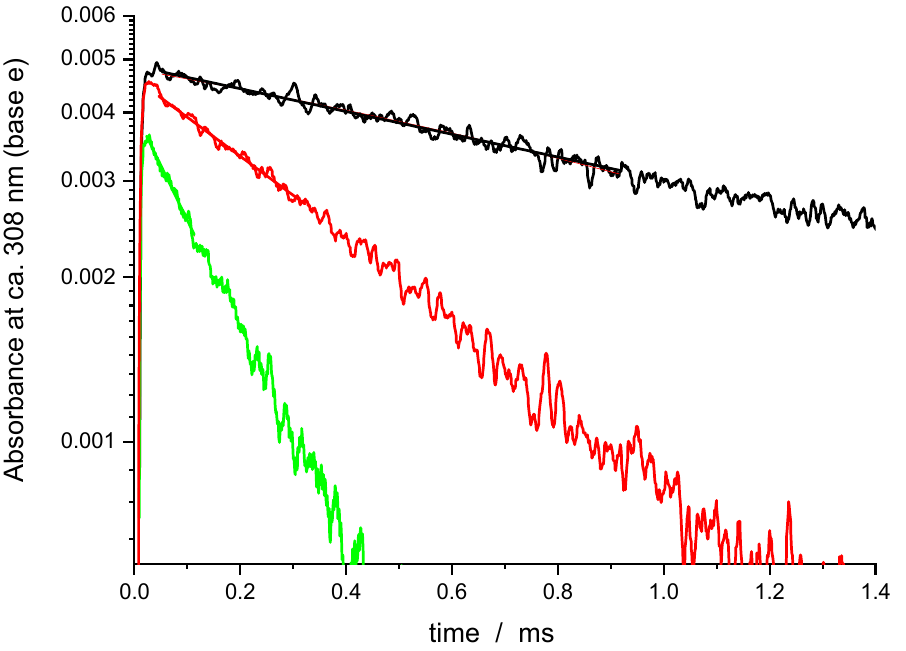
Figure 1. Sample transient absorption signals of OH in a O 3 /O 2 /H 2 O/He mixture at 266 nm and T = 411 K. [O 3 ] = 3.43 × 10 14 , [H 2 O] = 2.3 × 10 16 , [He]= 1.8 × 10 19 . Black—without DMMP, red—[DMMP] = 3.67 × 10 14 molecule cm −3 , green—[DMMP] = 10.9 × 10 14 molecule cm −3 . Solid lines—exponential fits of ca. 1/3 of the initial amplitude (see text).